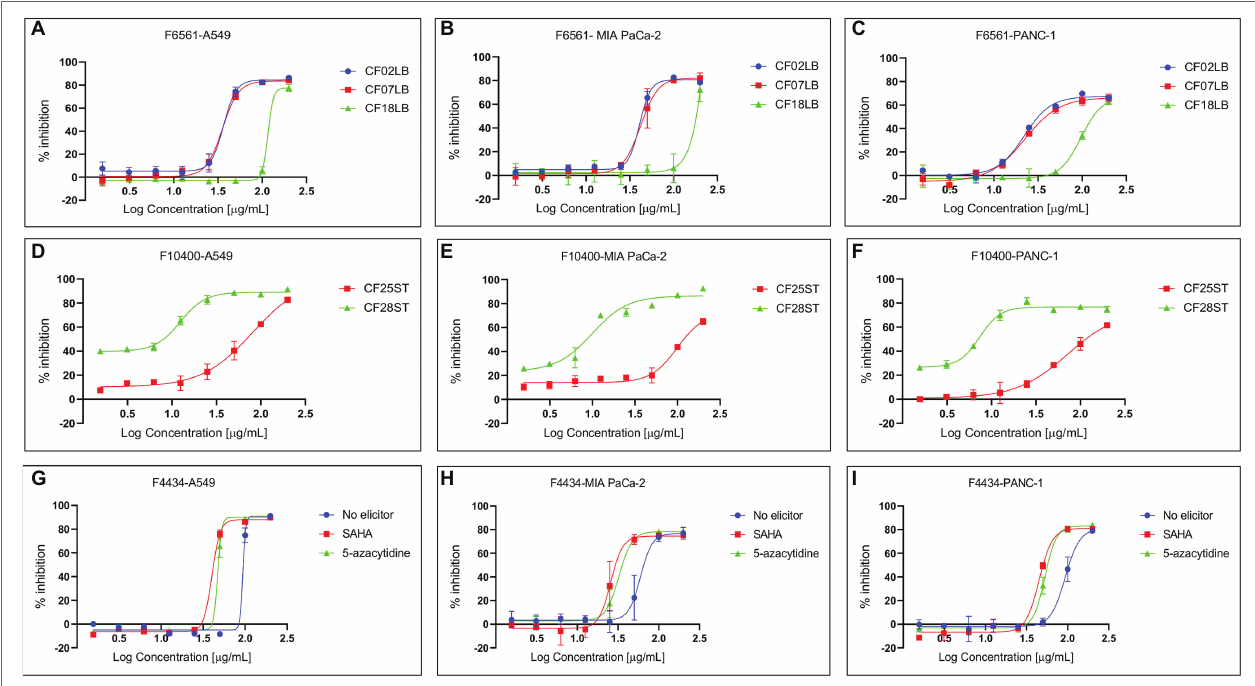
FIGURE 5 | Differential expression of cytotoxic activity of extracts derived from three fungal endophytes against three cancer cell lines—A549, MIA PaCa-2, and PANC-1. (A–C) Show the activity of extracts from F6561 grown in three different liquid media CF02LB, CF07LB, and CF18LB, (D–F) show activity of extracts derived from F10400 grown in two solid media CF25ST and CF28ST, while (G–I) show the activity of extracts from strain F4434 grown in CF02LB media in the absence of a chemical elicitor (control) and in the presence of 50 μ M 5-azacytidine and 100 μ M